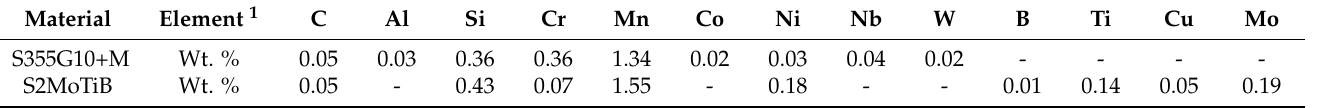
Table 1. Chemical composition of base material and filler